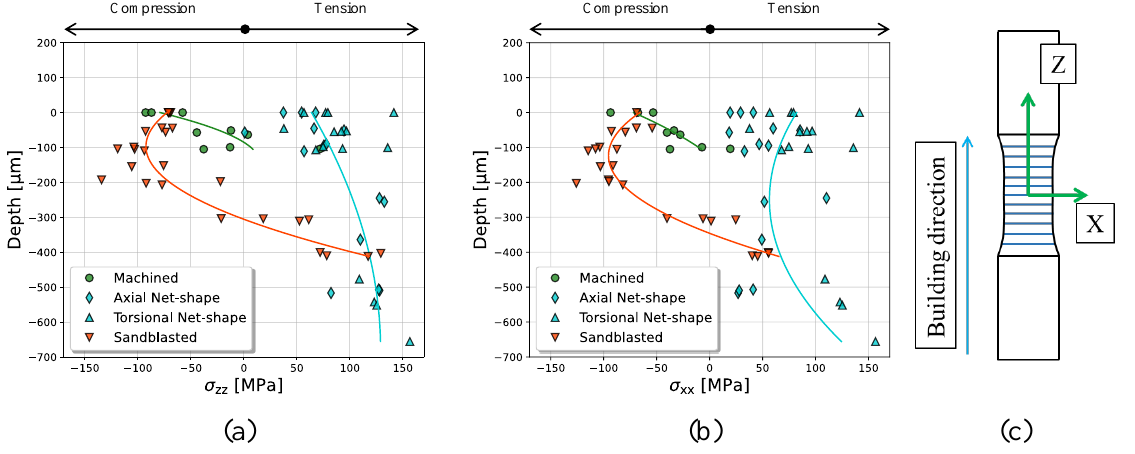
Figure 4. Comparison of measured residual stresses of machined, net-shape and sandblasted compo- nents: ( a ) σ zz ; ( b ) σ xx ; ( c ) schematic of the measuring